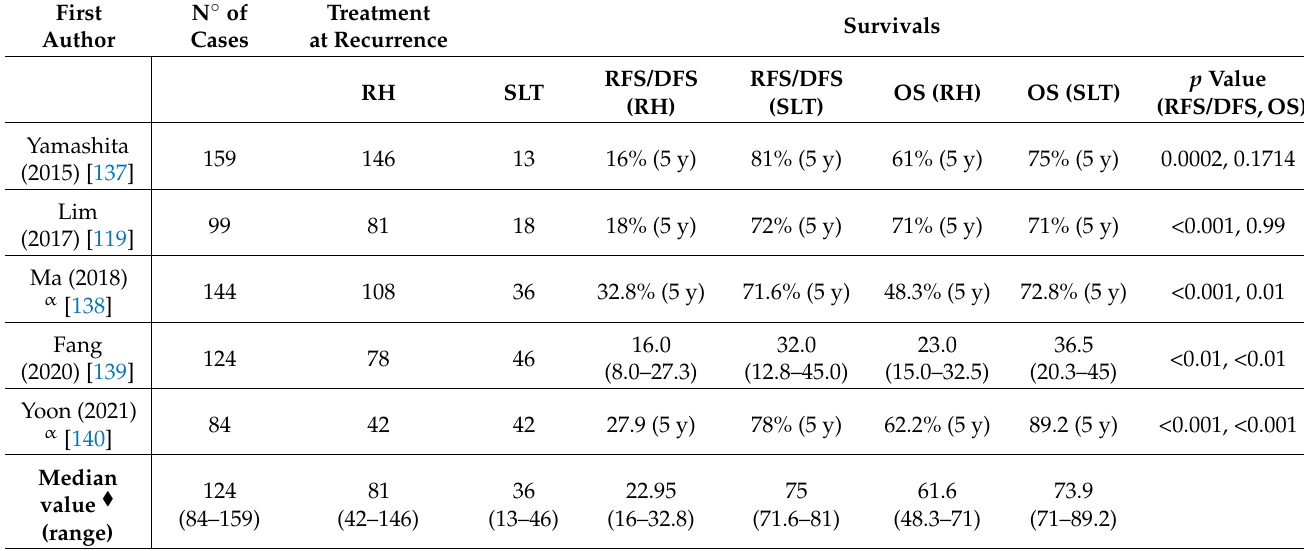
Table 2. Studies comparing redo hepatectomy versus salvage liver